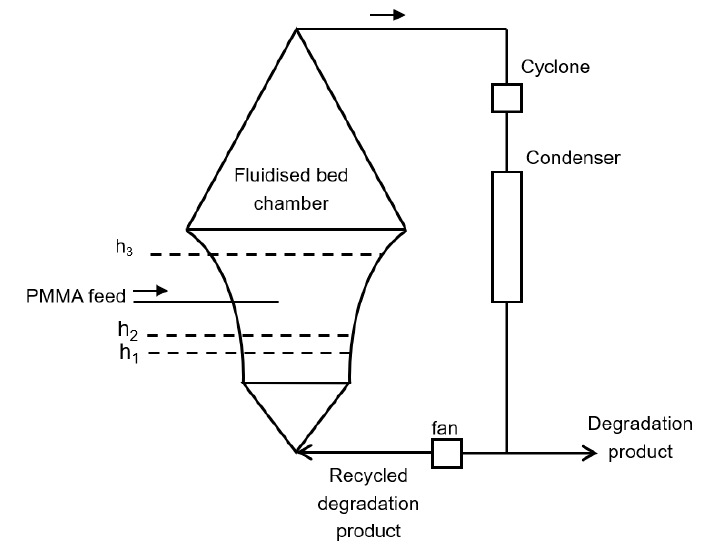
Figure 21. Fluidized bed reactor technology as proposed by Vaughan et al. [127].